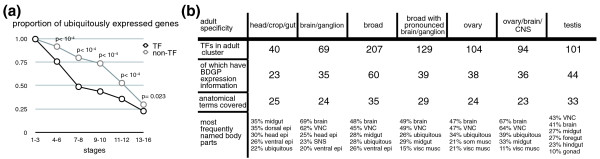
Tissue specificity of site-specific transcription factors. (a) Proportion of ubiquitously expressed genes along the developmental time axis, separated into TFs and non-TFs. The expression patterns of TFs and non-TFs are significantly different between stages 4 and 12 (P < 10-4), with less ubiquitous and more restricted expression patterns for the TFs. (b) Adult specificity. Gene expression clusters with adult tissue-specificity were queried for their specificity in late embryonic development (BDGP dataset stages 13 to 16). Shown is the expression breadth as the number of anatomical structures used in the annotation, as well as the percentage of genes with frequently encountered annotations. For example, for the 40 TFs primarily expressed in adult head, crop and gut, there is embryonic expression information for 23 of them. These genes are most frequently annotated for expression in the midgut (35%) and dorsal epidermis (35%). Interestingly, very frequently, adult tissue-specific TFs are involved in embryonic nervous system development. CNS: central nervous system; SNS: stomatogastric nervous system; VNC: ventral nerve cord.